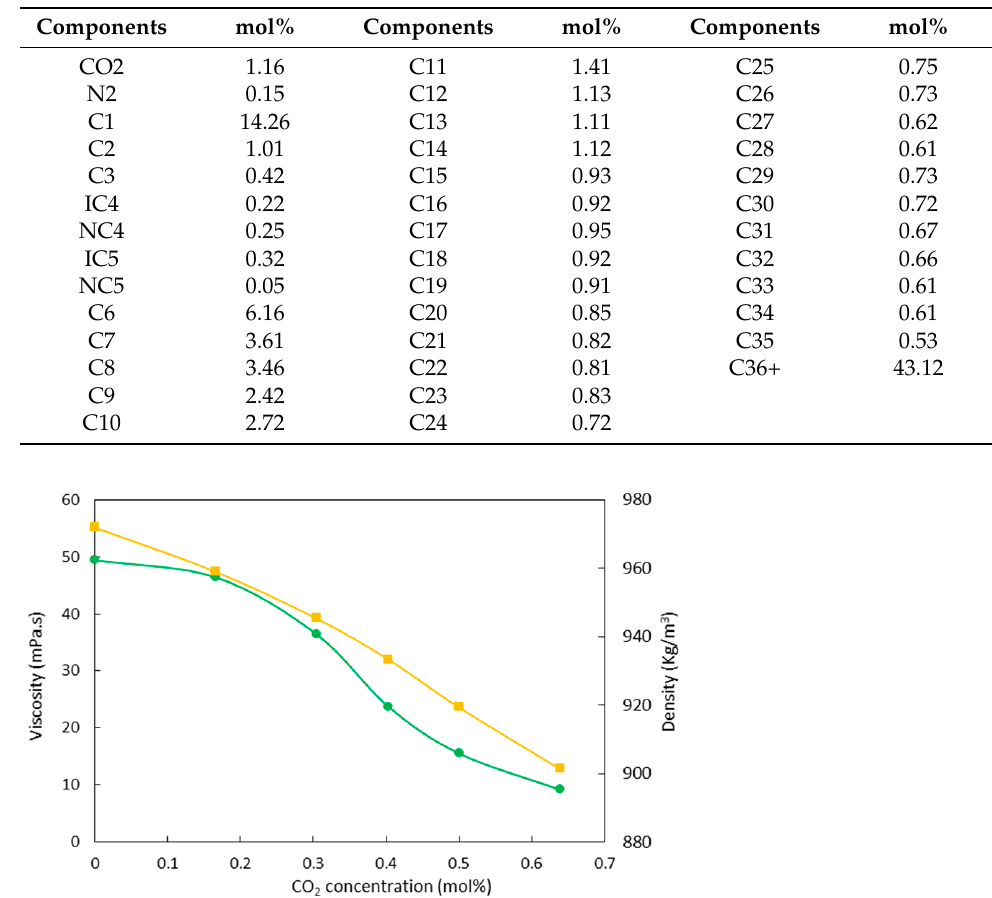
Table 2. Viscosities and densities of the heavy oil–CO 2 system with different CO 2 concentrations.